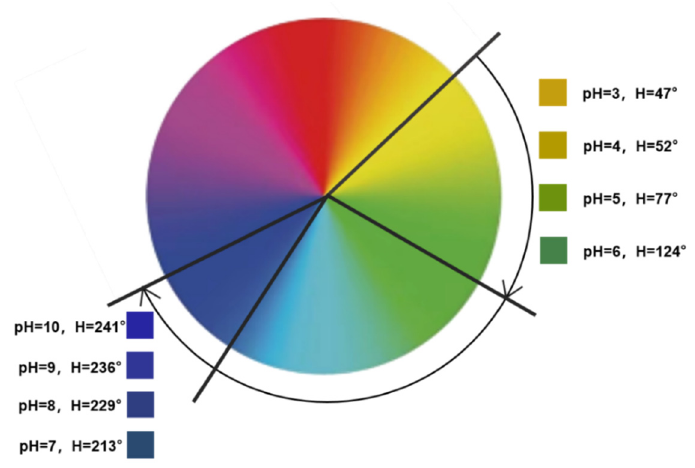
Figure 11. The H-value range of nanocapsules under different pH values (pH 3–10).